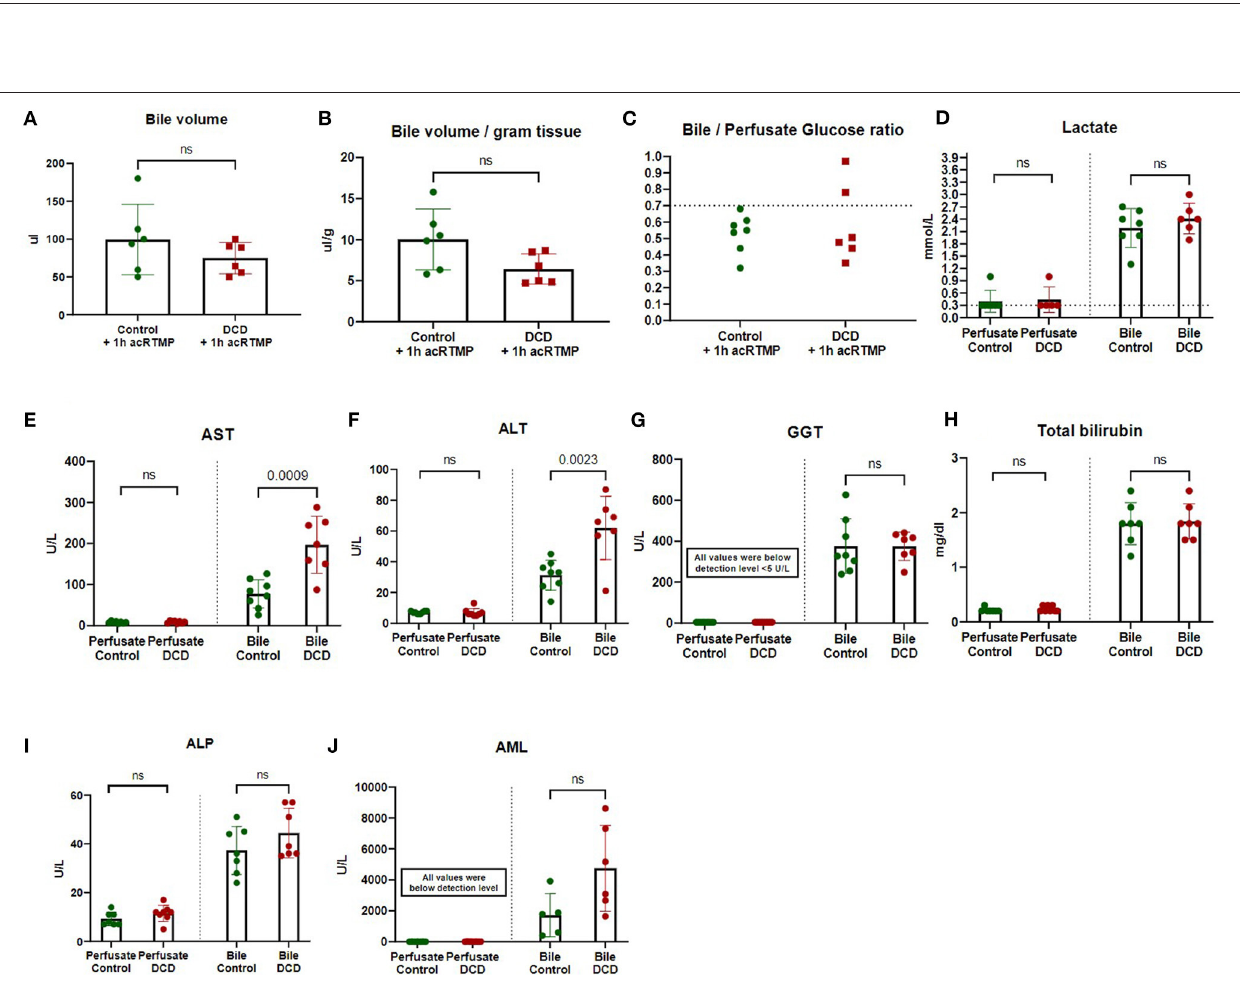
Frontiers in Medicine |